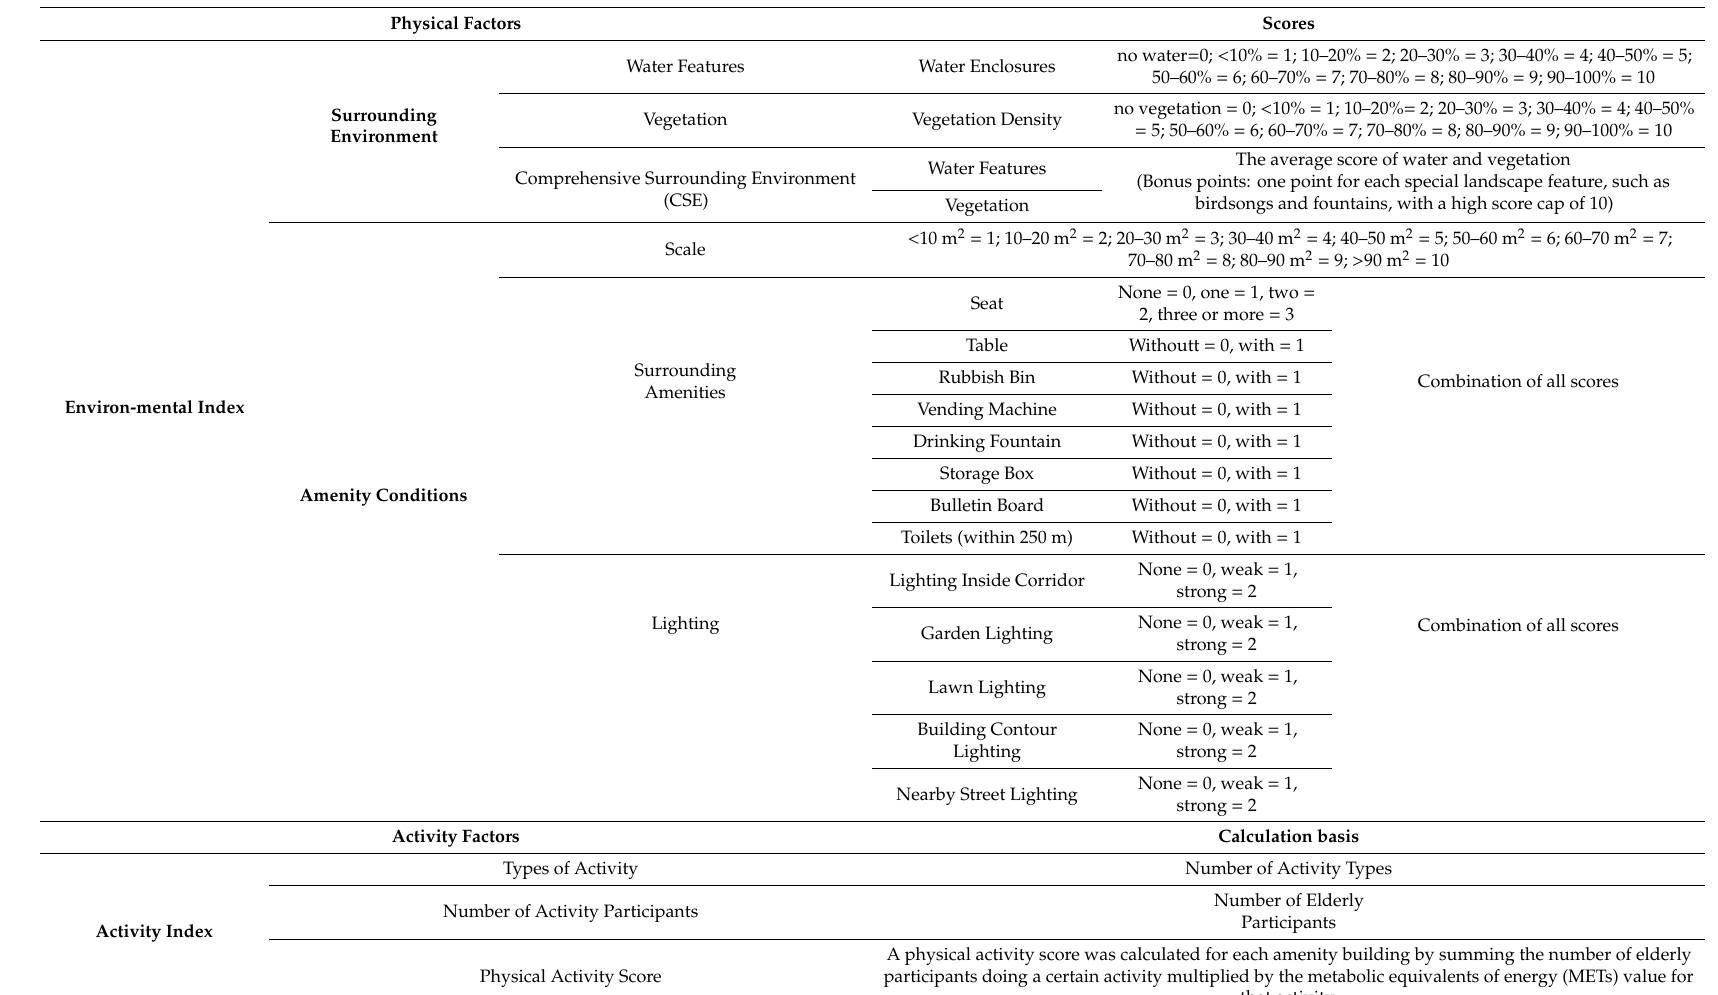
Table 1. Measured factors and weight